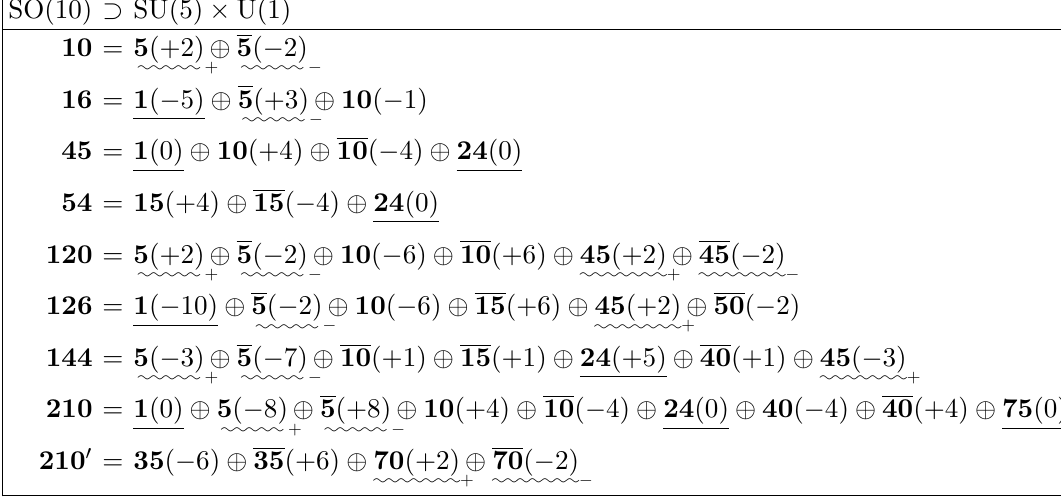
p 5) (cid:0) 1 ) of the SM gauge group G 321 2